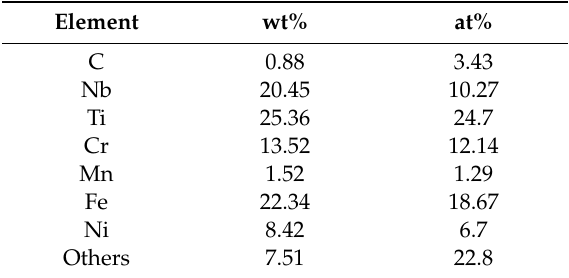
Figure 7. SEM micrographs and EDS spectra of the precipitates on the crack surface. Table 4. Chemical composition of point A by EDS.